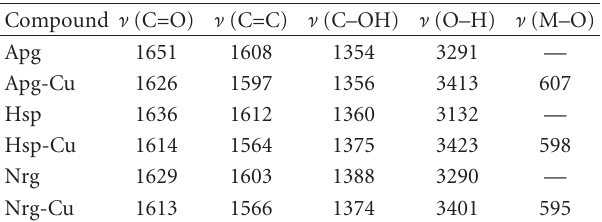
Table 1: FT-IR spectrum data (cm − 1 ) for the free ligands Apg, Hsp, Nrg, and their Cu(II) complexes